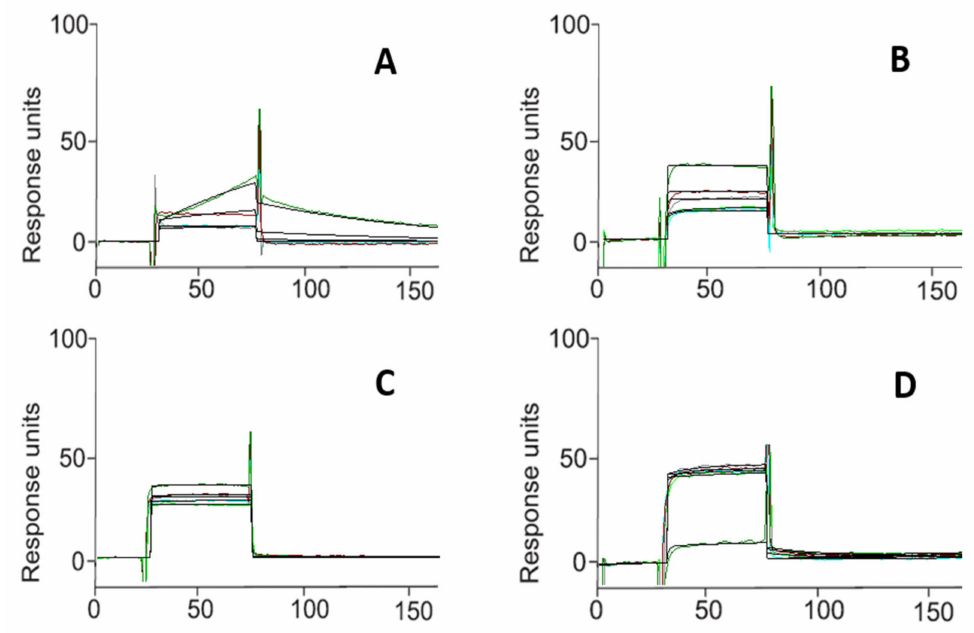
Figure 1. Surface plasmon resonance sensorgrams acquired for HAA 2020 ( A ), 4 ( B ), 5 ( C ) interacting with Hsp90 α and for the positive control 17-AAG ( D ). Each compound was injected onto an Hsp90 α modified sensor chip at 6 ( n = 3) di ff erent concentrations in the range 0.025–4.000 µ M.